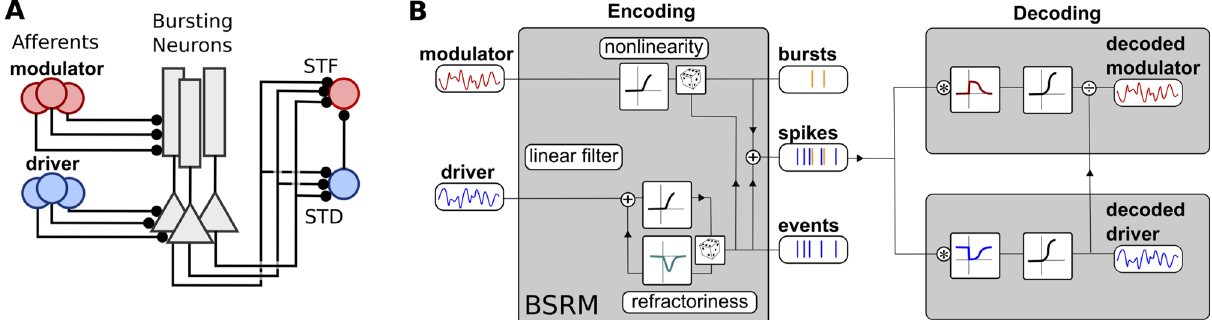
Figure 2. Schematic illustration of the simulation paradigm. ( A ) We model a population of bursting neurons receiving inputs from two distinct pre-synaptic populations and projecting to two post-synaptic cells with different short-term plasticity (short-term depression (STD); short-term facilitation (STF)). ( B ) Each bursting neuron is modelled with a Burst Spike Response Model (BSRM), which utilises distinct inputs to generate a bursty spike train (see supplementary Fig. S1 for sample spike trains). The driver input (blue, left) controls the event train, which is generated stochastically (illustrated by the die in the lower part) with a firing intensity that is a nonlinear readout of the input. A modulator input (red, left) controls the burst probability via another nonlinear readout. Upon event generation, a burst can be generated according to a Bernoulli process (upper die). Spike trains from this encoding cell population contain elements of both inputs. Two decoding neurons attempt to demultiplex the original signals. Different properties of short-term plasticity (illustrated by different linear filters before a nonlinear readout) extract bursts and events. A division from the event decoding cell is included to turn the estimate of the burst rate into an estimate of the burst probability, an essential step for extracting the modulator